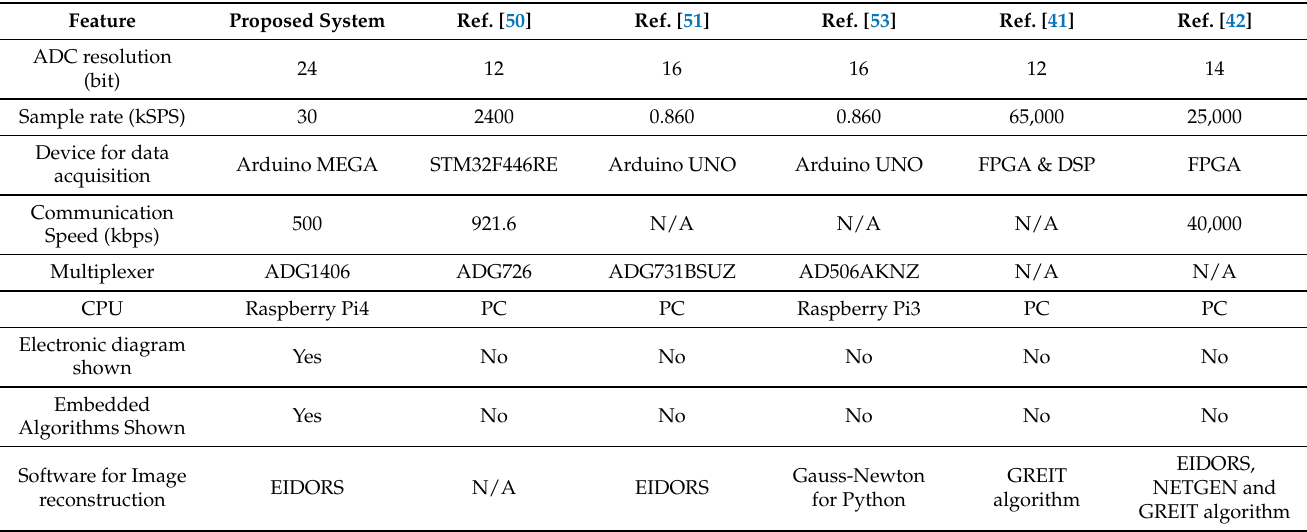
Table 5. Comparison of proposed EIT system versus other related